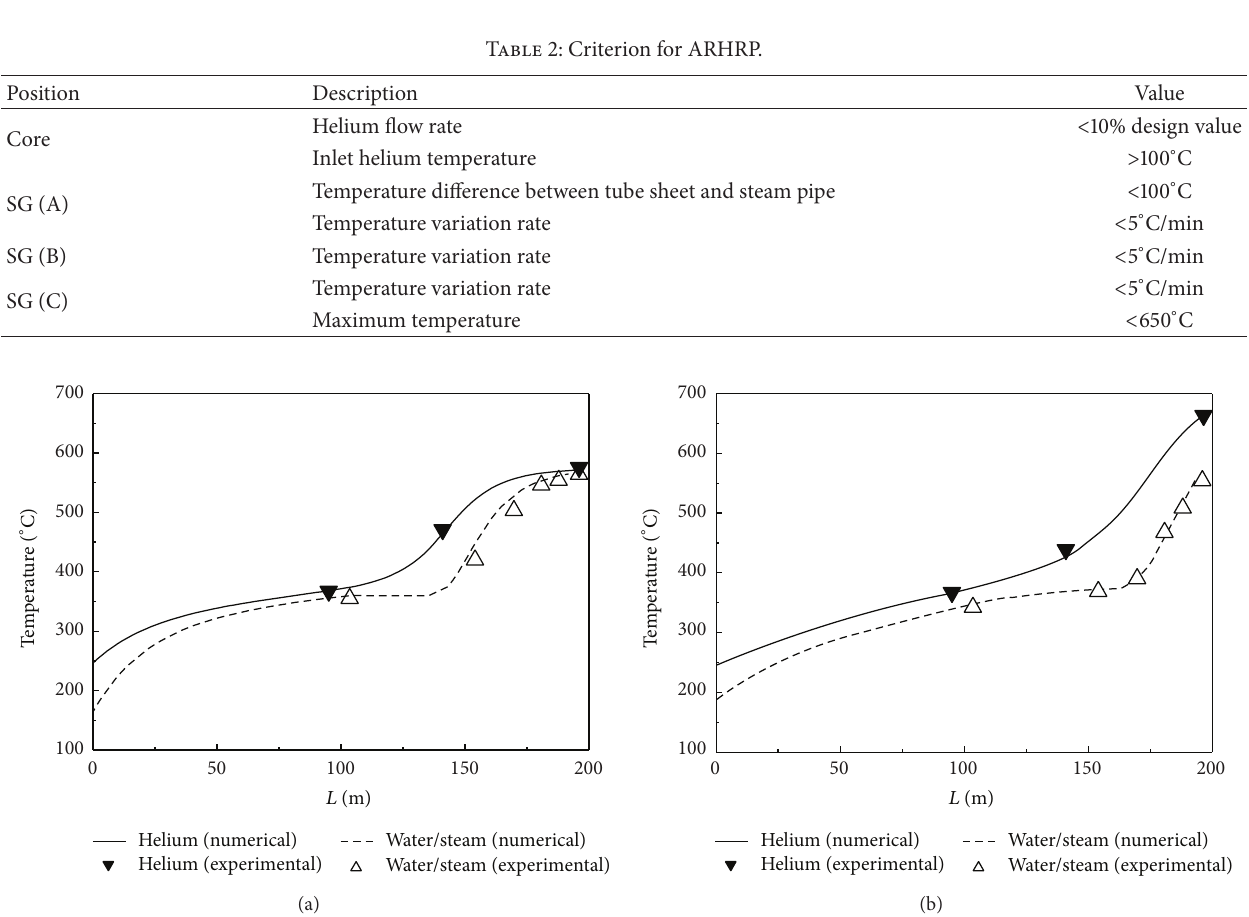
Figure 4: Validation of numerical model by THTR-300 experiments: (a) temperature distribution under 40% power load and (b) temperature distribution under 100% power